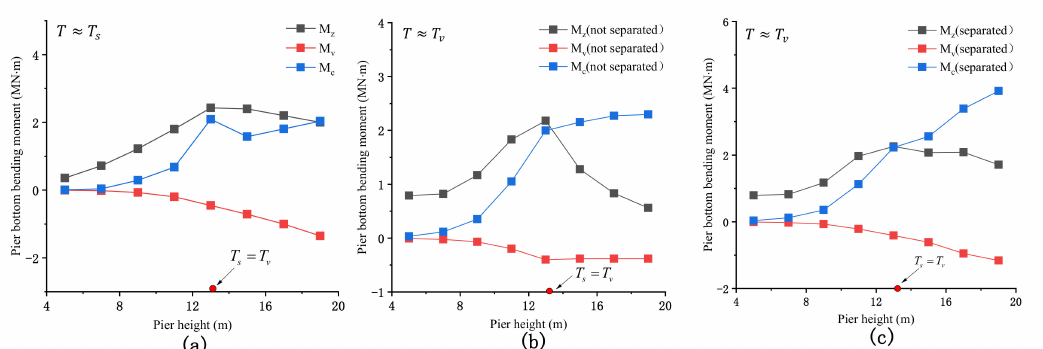
Figure 10. Calculated values of the base of the pier’s bending moment at different pier heights: ( a ) the values of bending mo- ments when T ≈ T s ; ( b ) ignoring the values of bending moments under separation conditions when T ≈ T v ; ( c ) considering the values of bending moments under separation conditions when T ≈ T v .